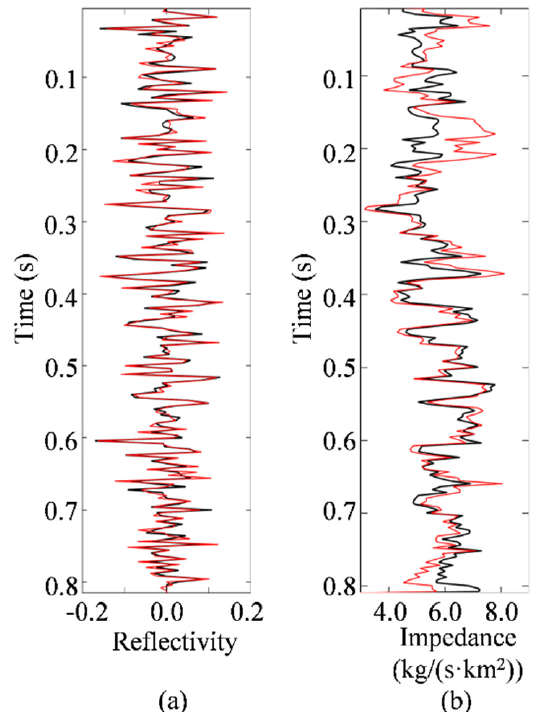
Figure 3. The inverted reflectivity series and impedance from L2RI performed on the noise-free synthetic trace. ( a ) Reflectivity series; ( b ) impedance.